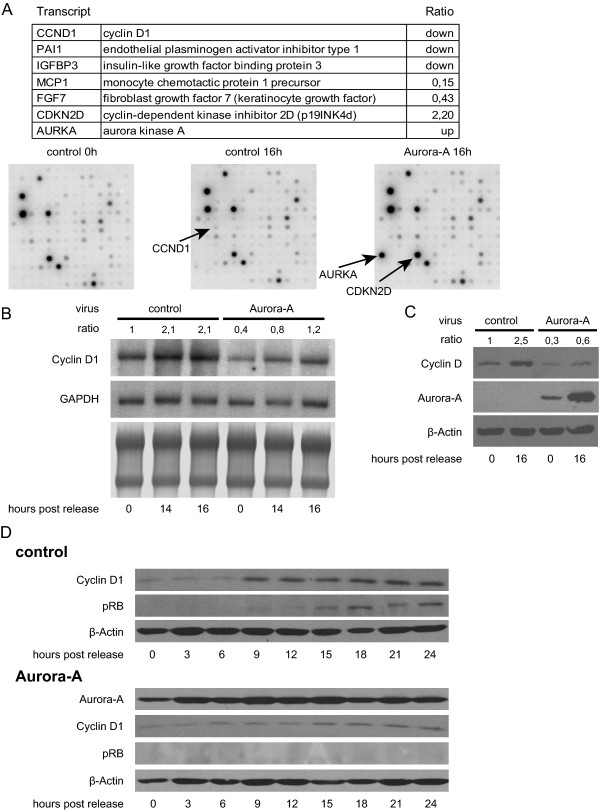
Identification of modulated gene expression caused by Aurora-A expression during G0/G1 progression. 24 hours after serum removal, arrested Wi-38 cells were infected with adenoviruses expressing either Aurora-A or lacZ (control). Serum was added 48 hours after infection and cells were harvested at the times indicated. Total RNA was extracted and Clonetech human Atlas 1.2 cDNA expression array analyses were performed. (A) A list of the genes, which fail to respond to serum addition in Aurora-A overexpressing cells is presented in the upper panel. Ratio given indicates the difference in mRNA expression compared to controls. The lower panel highlights the region of the array containing the probes for Cyclin D1 and p19INK4d. (B) Verification of the array data was done using Northern blot analysis with a Cyclin D1 probe spanning the first 350 nucleotides of the Cyclin D1 coding sequence and a probe for GAPDH from nucleotides 192 to 549 for normalization. One of 3 Northern blots from independent experiments is shown. The expression level ratios of Cyclin D1 were calculated after densitometric analysis using ImageQuant software (Molecular Dynamics, Sunnyvale, CA) and normalized to GAPDH. Serum-deprived control cells were set to 1. (C) Immunoblot of equally treated cells was performed and assayed for Cyclin D1 protein expression. (D) At the indicated times, immunoblotting of serum released cells expressing either lacZ (control) or Aurora-A was performed with the antibodies indicated.